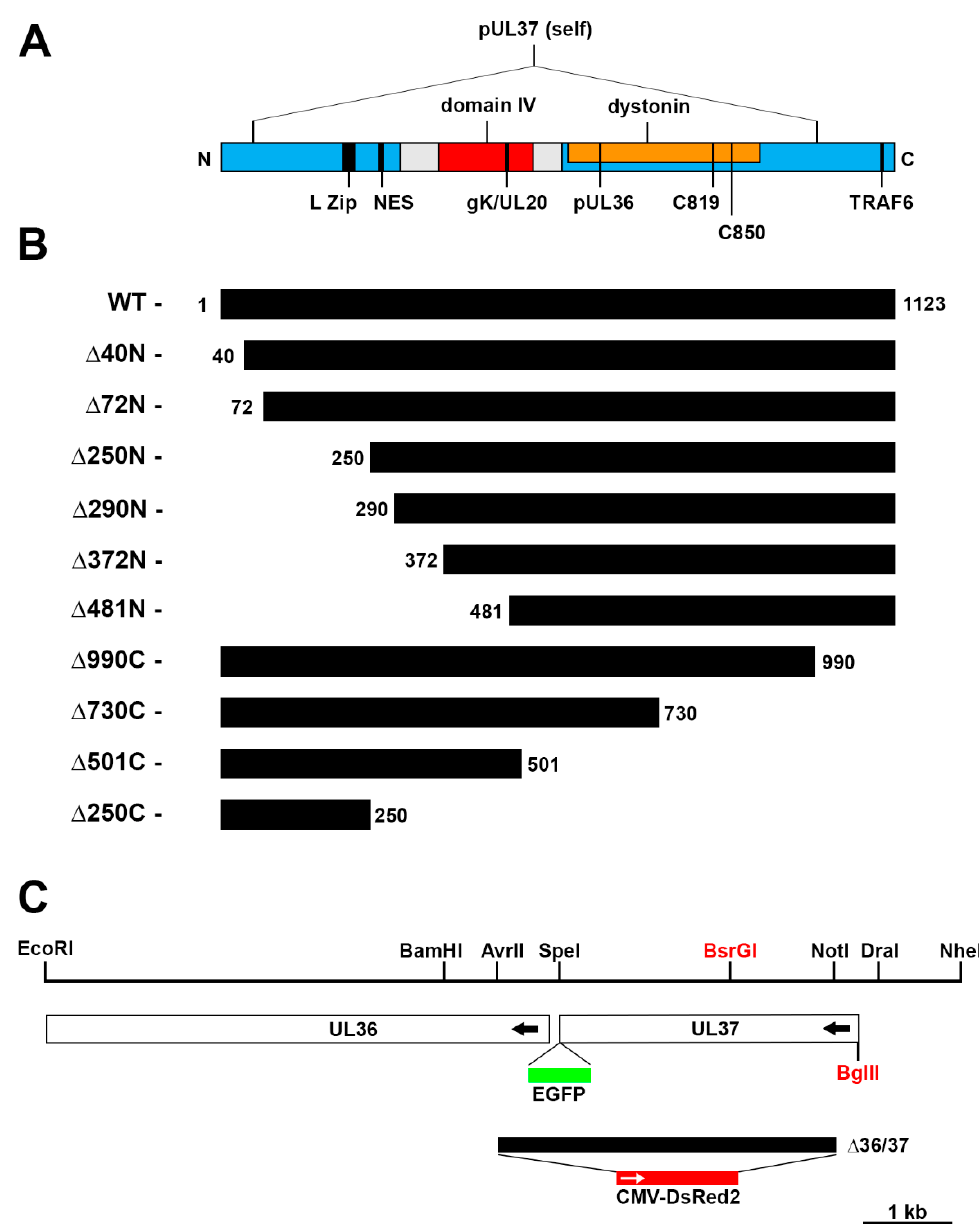
Figure 1. Functional and interaction domains of the HSV-1 pUL37. ( A ) The carton illustrates the 1123 amino acid linear pUL37 polypeptide. The motifs identified to act as a nuclear export signal (NES), a leucine zipper (L Zip), deamidase active sites (C819 and C850), and the virulence R2 residues in domain IV (red) are shown, as well as the self (blue), pUL36, gK / pUL20 (474–480), dystonin (orange), and TRAF6 interaction domains [38,45,66,67,71]. ( B ) Polypeptide truncations of the N- and C-terminus of pUL37 were generated molecularly and transferred into the HSV-1 genome using marker-rescue / marker-transfer methods. Mutant polypeptides expressed a C-terminal EGFP fusion. ( C ) Carton of the UL37 and UL36 genetic locus of HSV-1. The figure shows the restriction enzyme fragments used to clone different regions of UL37 and to engineer mutant genes. These include the site of the insertion of EGFP ORF and the region of a UL36–UL37 double deletion followed by insertion of the CMV-DsRed2 cassette. Engineered restriction enzyme sites are shown in red.